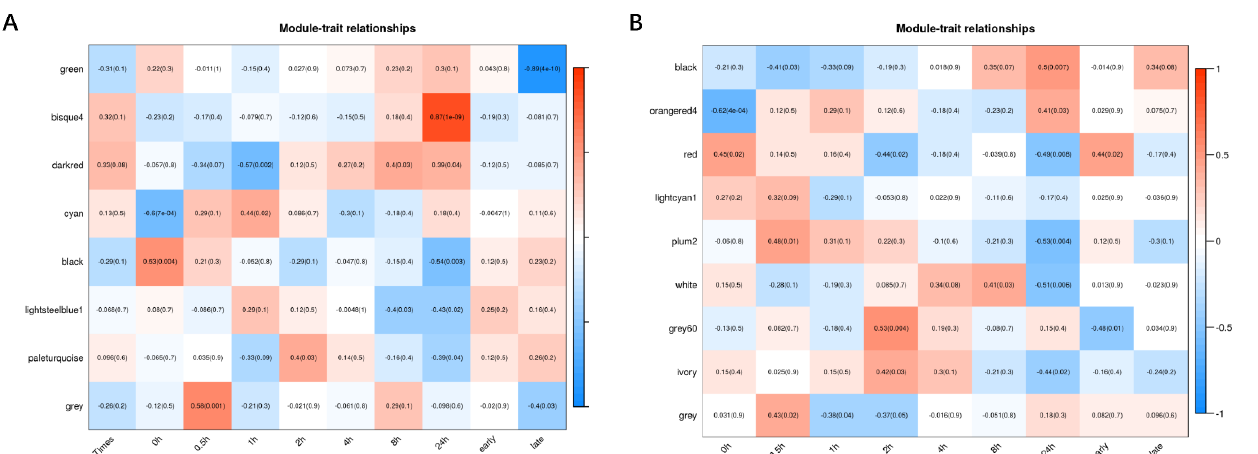
Figure 2. Gene modules identified by weighted gene co-expression network analysis (WGCNA) of IR64 ( A ) and Koshihikari ( B ). Gene dendrogram obtained by clustering the dissimilarity based on consensus Topological Overlap with the corresponding module colors indicated by the color row. Each colored row represents a color coded module, which contains a group of highly connected genes.